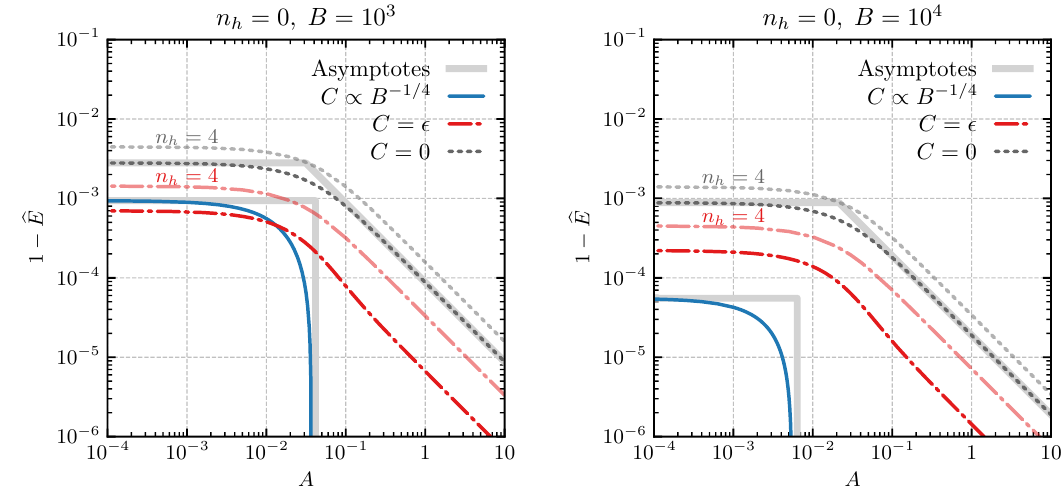
Figure 3 . The fractional binding energy with no heavy quarks (left panel) and three heavy quarks (right panel). The three curves correspond to different values of the constant B ; see text for details. The thick grey lines behind each curve (left panel) are obtained from the analytic expressions in the two limits of large and small A .